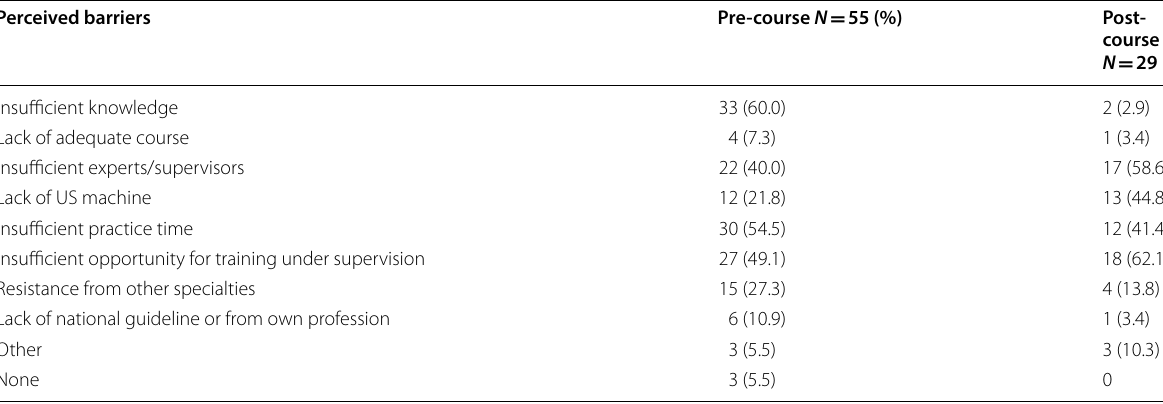
Table 3 Perceived barriers for performing